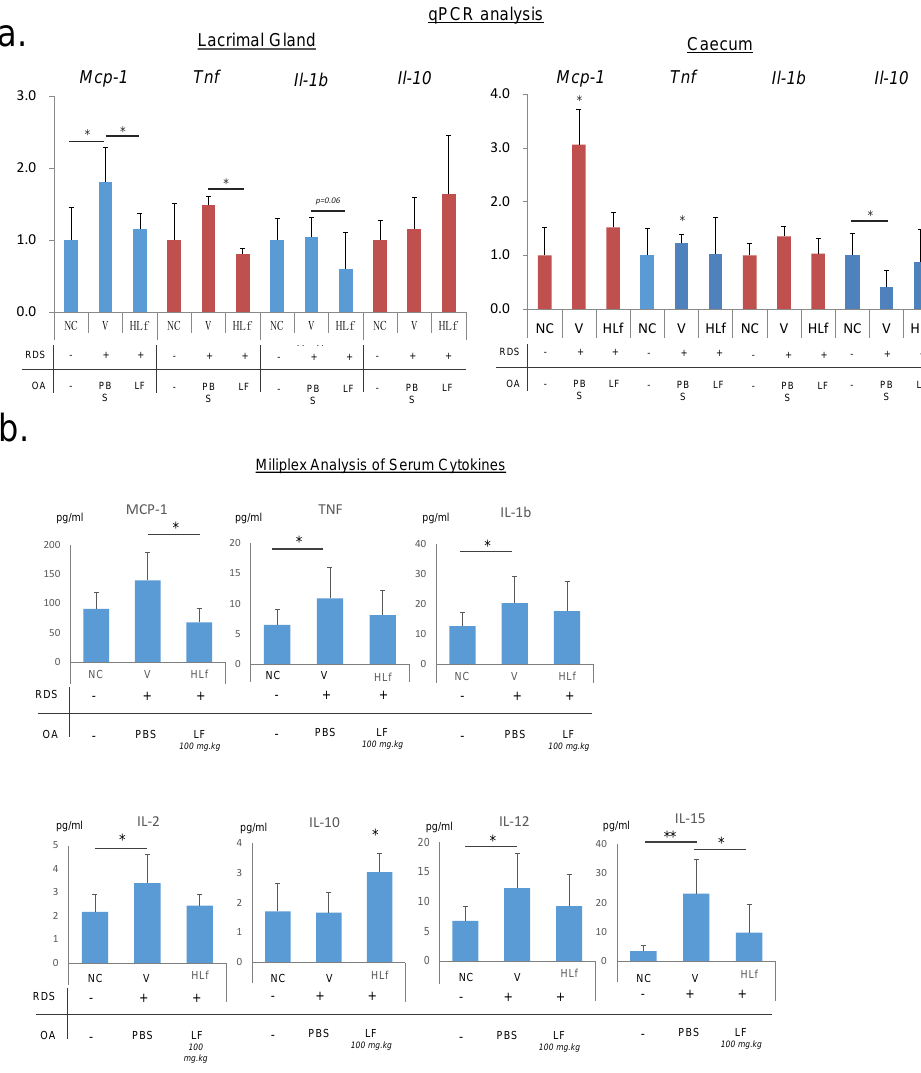
Figure 2. Cytokine analysis. ( a ) qPCR analysis of the expression of MCP1 , TNF , IL-1b , and IL-10 genes in the lacrimal gland and caecum. β -actin was used as the housekeeping gene. ( b ) Milliplex assay systemic alterations in inflammation. An apparent increase in a level of expression and concentration of cytokines was observed in V mice relative to that observed in HLF mice, suggesting a protective function of LF, leading to a reduction in